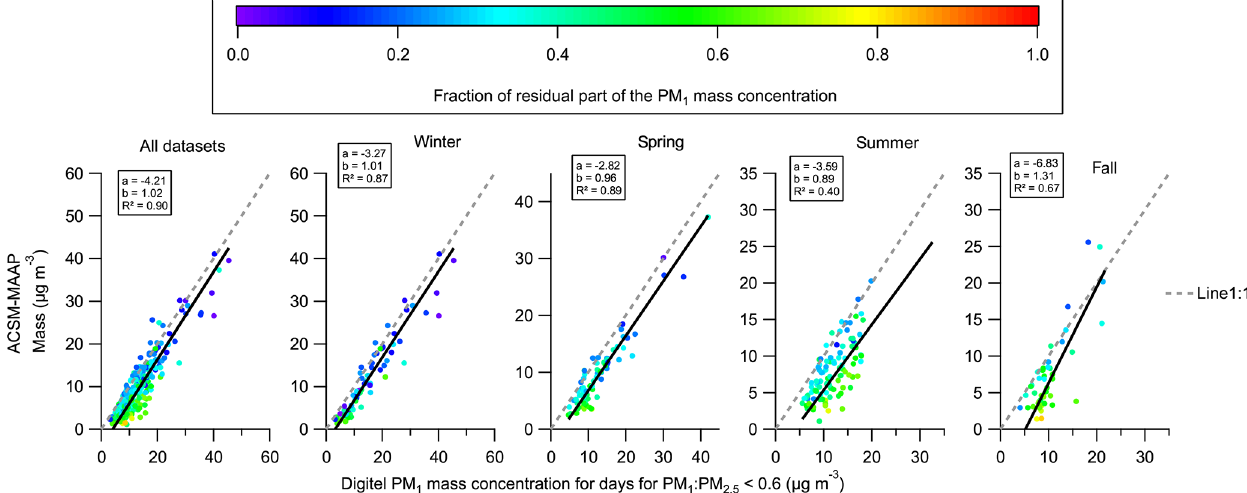
Figure 8. Influence of the residual mass fraction on the PM 1 filter to the mass closure with online ACSM–MAAP-derived mass concentration.